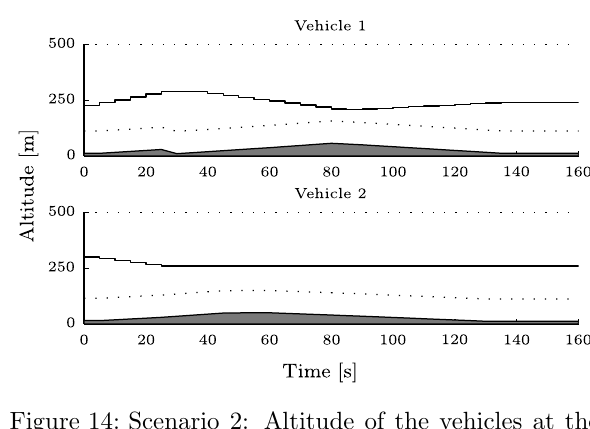
Figure 14: Scenario 2: Altitude of the vehicles at the final iteration. The shaded region is the ter- rain height, and the dashed lines are the up- per and lower bounds on the altitude of the vehicles. The actual altitude of the vehicles is depicted with the solid line. When arriv- ing at the final waypoint, the UAV will be brought down by remote